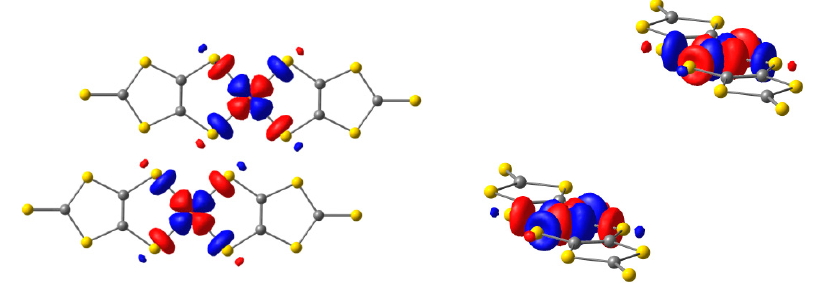
Figure 6. Top and side views of two neighbor [Cu(dmit) 2 ] − 2 complexes in the crystal, and the relative orientation of the SOMO on each complex. Yellow, red, and gray balls correspond to S, Cu, and C atoms, respectively.